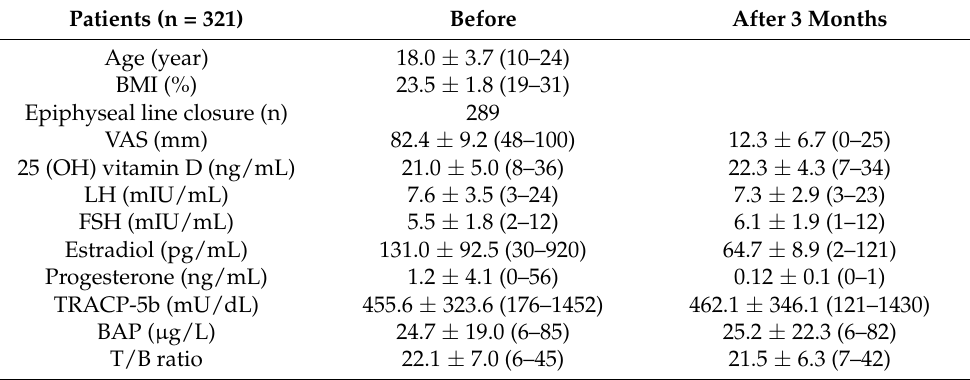
Table 1. Clinical characteristics and outcomes. Patients (n =